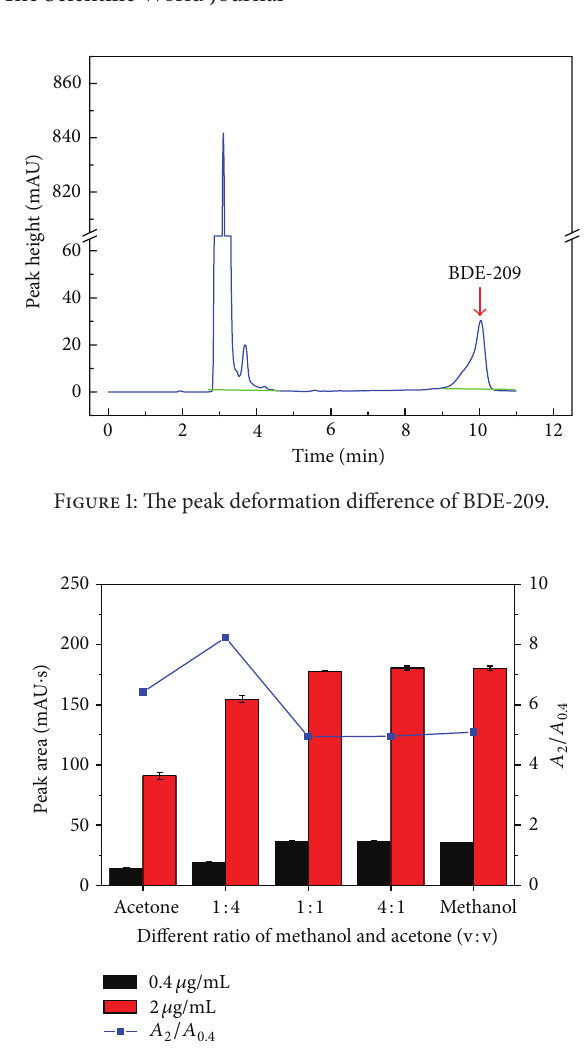
Figure 2: Different ratios of methanol and acetone on peak area of BDE-209 (blue line represents the peak area ratio of 2 𝜇 g/mL and 0.4 𝜇 g/mL solutions ( 𝐴 2 / 𝐴 0.4 ) at various amount of acetone).